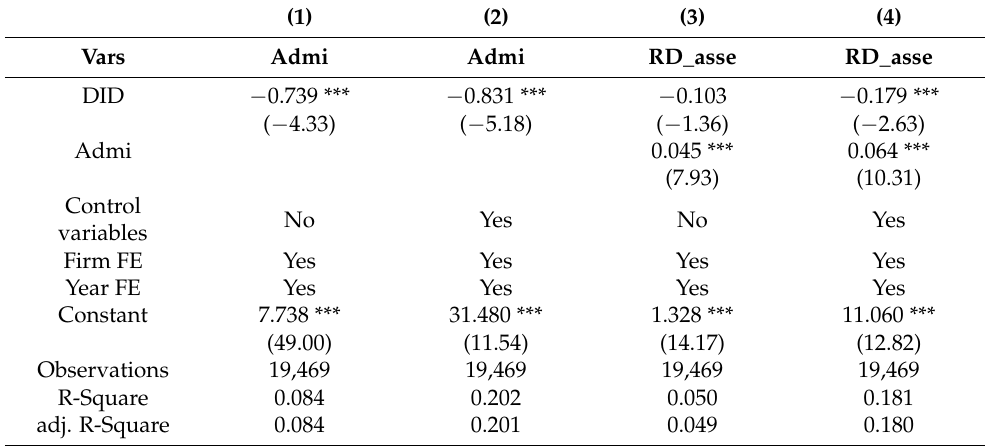
Table 7. Test of the mediating effect of corporate management